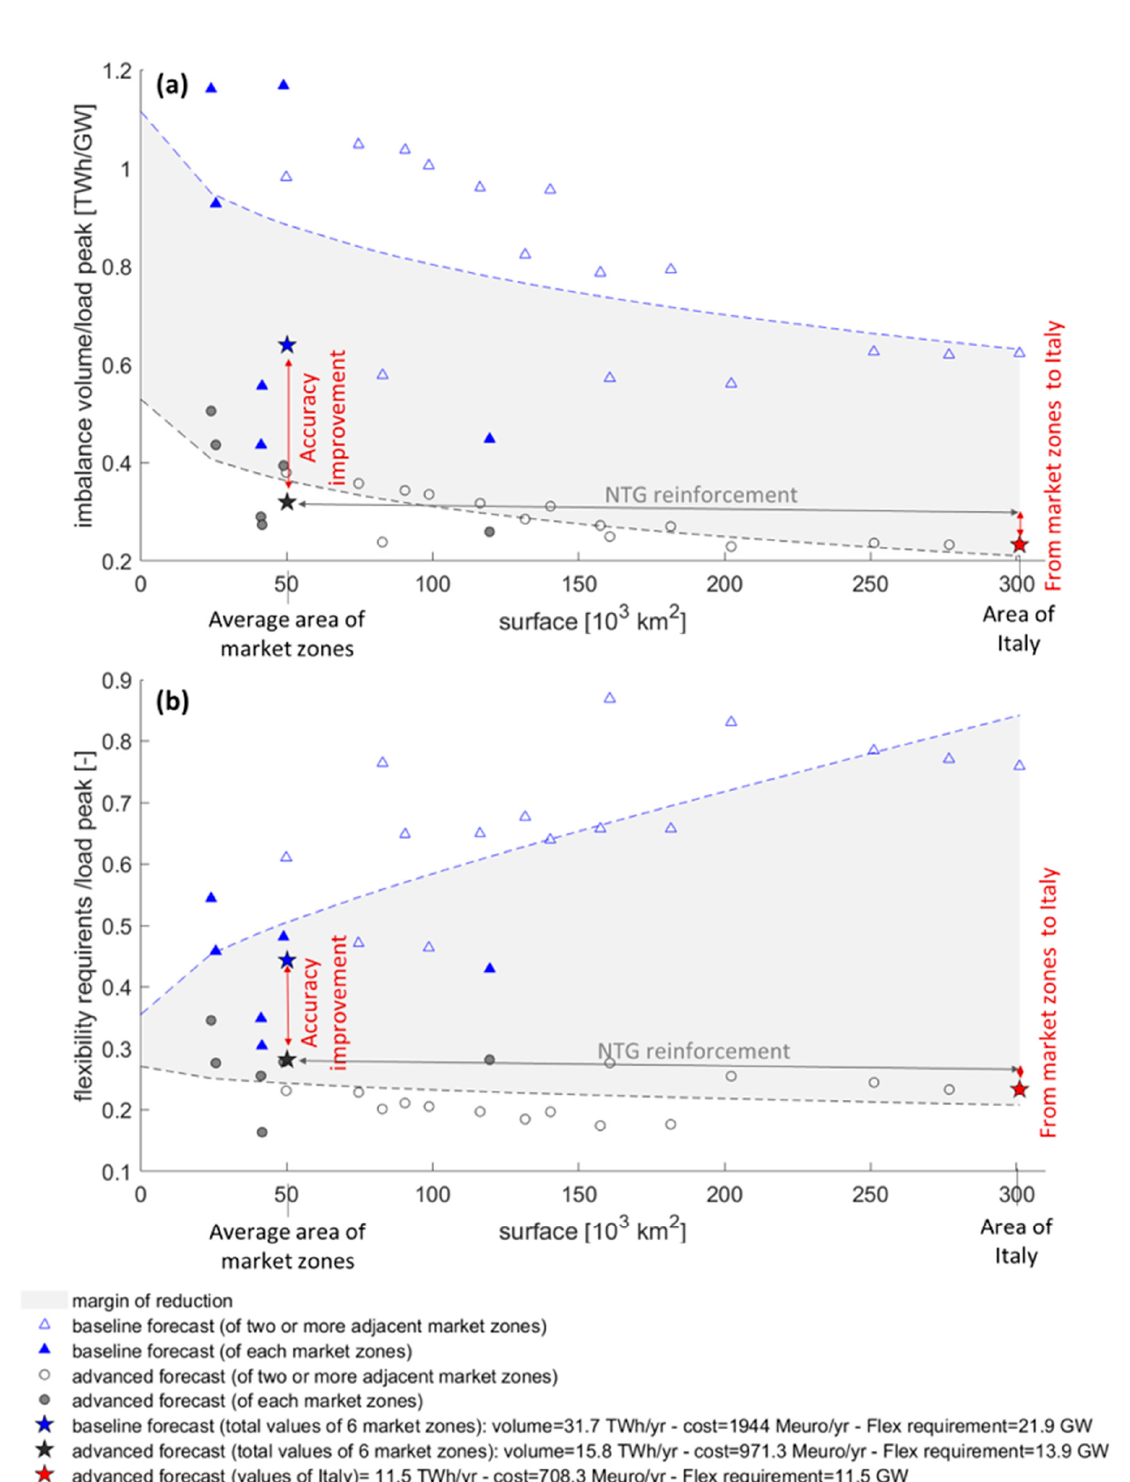
Figure 14. Margins of reduction of imbalance volumes ( a ) and flexibility requirements ( b ) related to more accurate forecast techniques and grid reinforcement. Filled markers are volumes/flexibility in a single market area. Empty markers are volumes/flexibility in a cluster of two or more of adjacent market zones between which national transmission grid (NTG) constraints have been removed. The blue/black stars represent the Italian imbalance volume resulting from the sum of the imbalances obtained from the netload prediction of each market zone.; red star is the Italian imbalance resulting from a single netload prediction at national level. The lines result from exponential fitting curves.